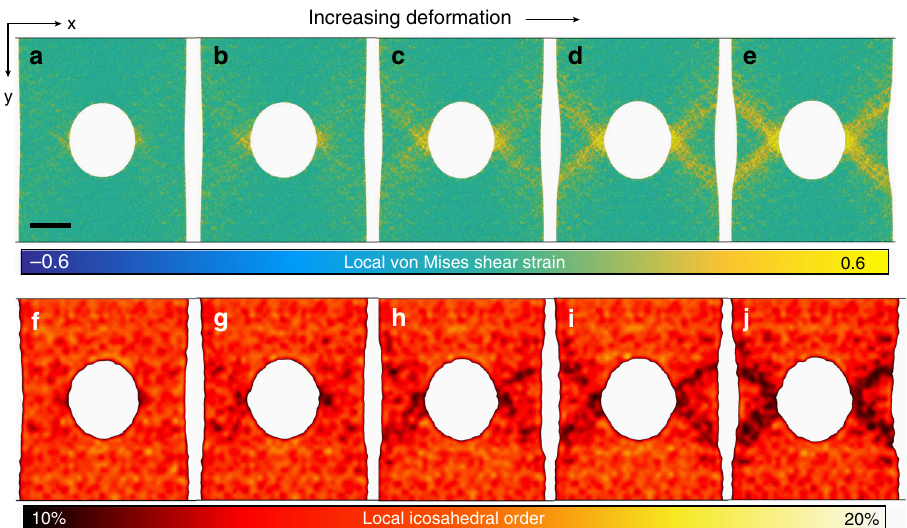
Fig. 3 Five frames of MD-simulated Cu 46 Zr 46 Al 8 MG at the strain of 4, 5, 6, 7, and 8% respectively, under uniaxial tensile deformation. The scale bar is 20 nm. a – e A color map of local von Mises shear strain. f – j The spatial distribution of local icosahedral order in coarse-graining scale, for such fi ve